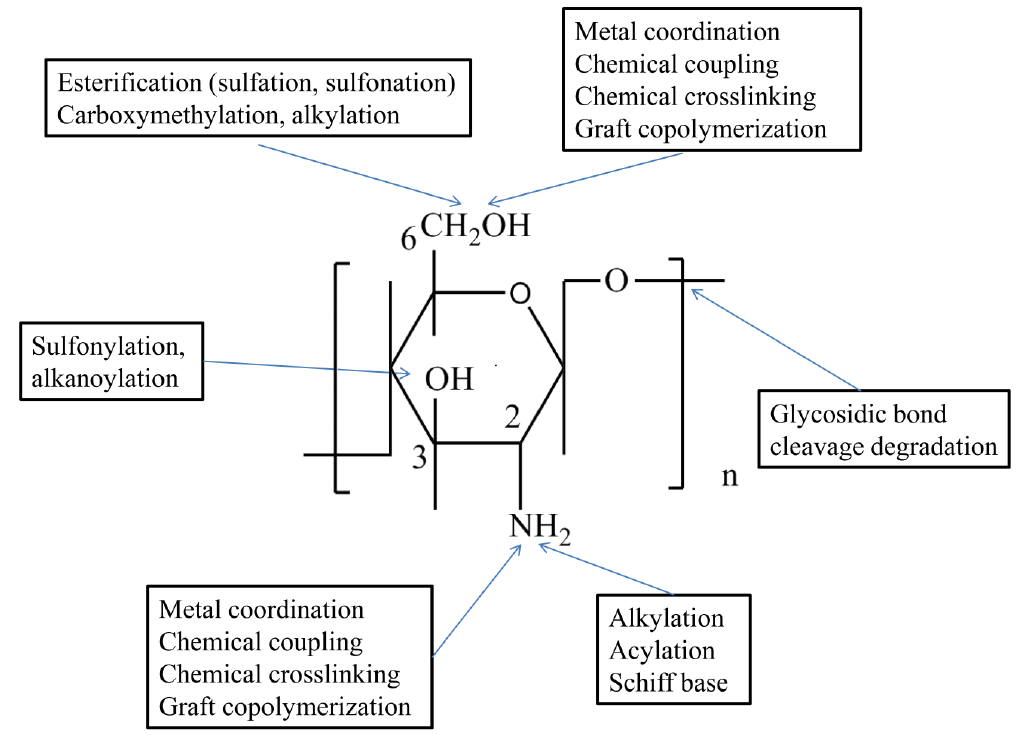
Figure 1. Schematic diagram of chitosan chemical reaction.